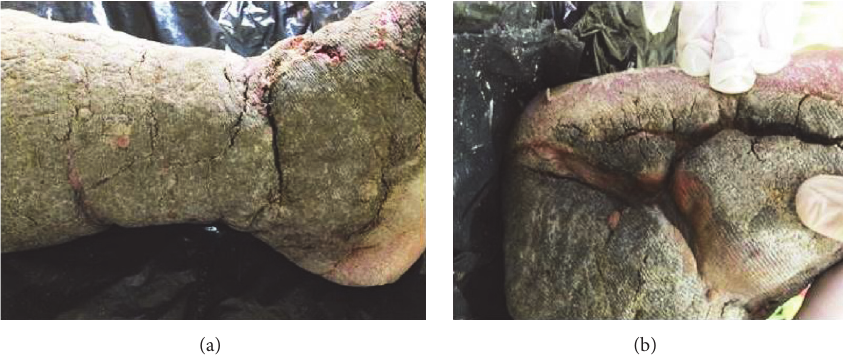
Figure 2: Evolution during therapy allowing the identification of grooves and the appearance of skin